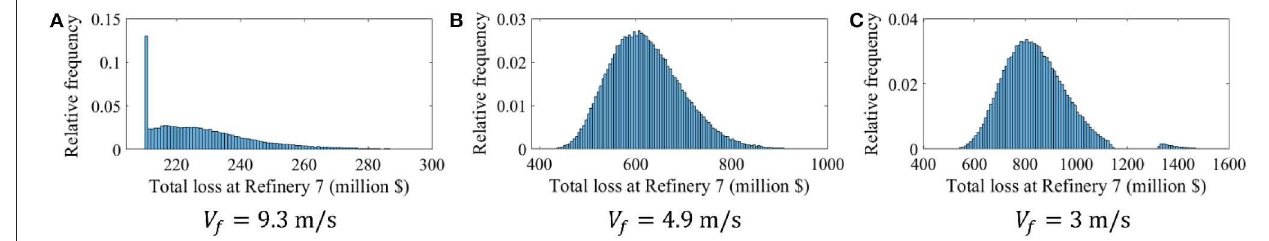
FIGURE 13 | Histogram of the total loss at Refinery 7 subjected to FEMA 33 with different forward speeds and SLR =